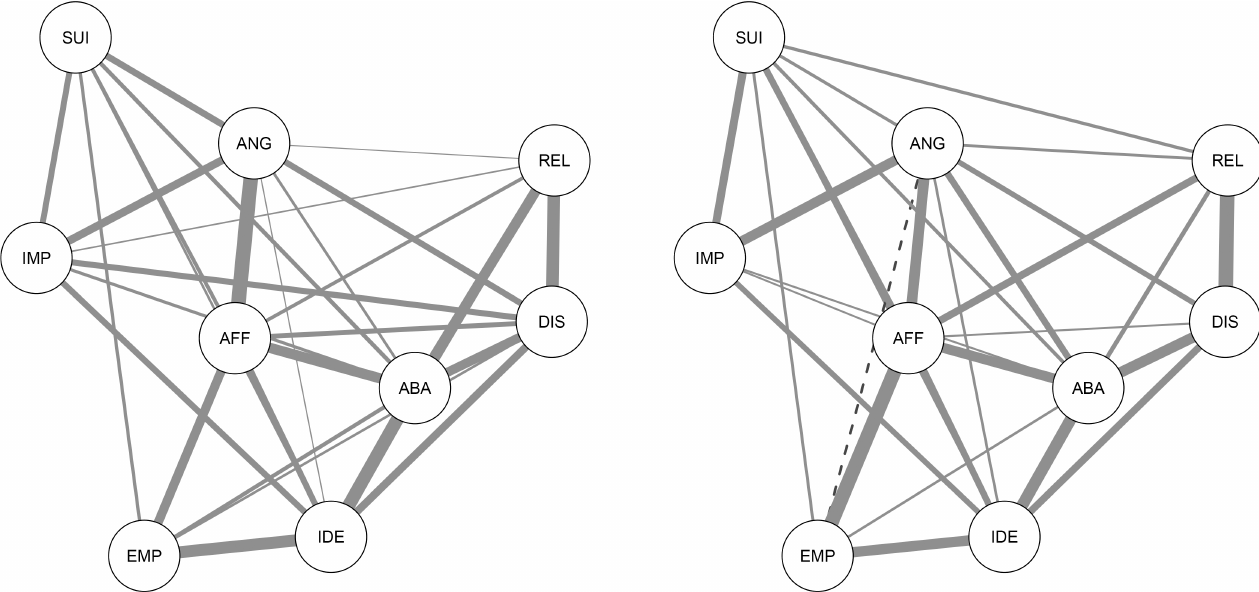
Fig 1. Networks of the 9 symptoms of Borderline Personality Disorder in the student (left panel) and clinical (right panel) samples. ABA: Efforts to avoid abandonment, REL: Unstable Relationships, IDE: Identity disturbance, IMP: Impulsivity, SUI: Suicidaland para-suicidalbehavior, AFF: Affective Instability, EMP: Chronicfeelings of emptiness, ANG: Difficulty controllinganger, DIS: Dissociation and paranoidideation.Darker edgesrepresent strongerlinks, full edgespositive links and dashededges negativelinks.